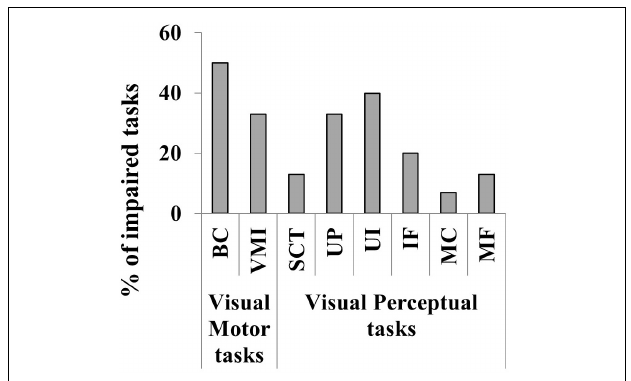
FIGURE 9 | Percentage of the impaired cognitive visual tasks in the 34 children evaluated. Visual motor skills (BC, Block Construction task; VMI, Developmental Test of Visual-Motor Integration) and Visual perceptual skills (STC, Street Completion Test; UP, colored photographs of objects viewed from unusual perspectives; UL, photographs illuminated in unusual ways; IF, Imagery Figures; MC, Matching Tasks for the ability to recognize semantic attributes of stimuli; MF, Matching Tasks for the ability to recognize functional attributes of